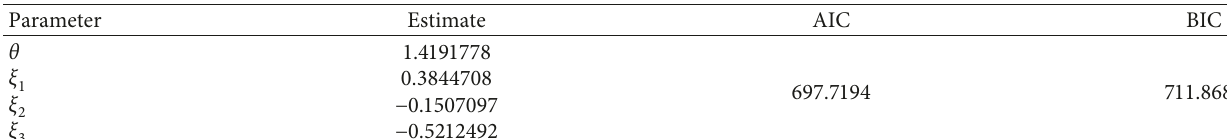
Table 2: Estimated parameters for the financial data with AIC and BIC.